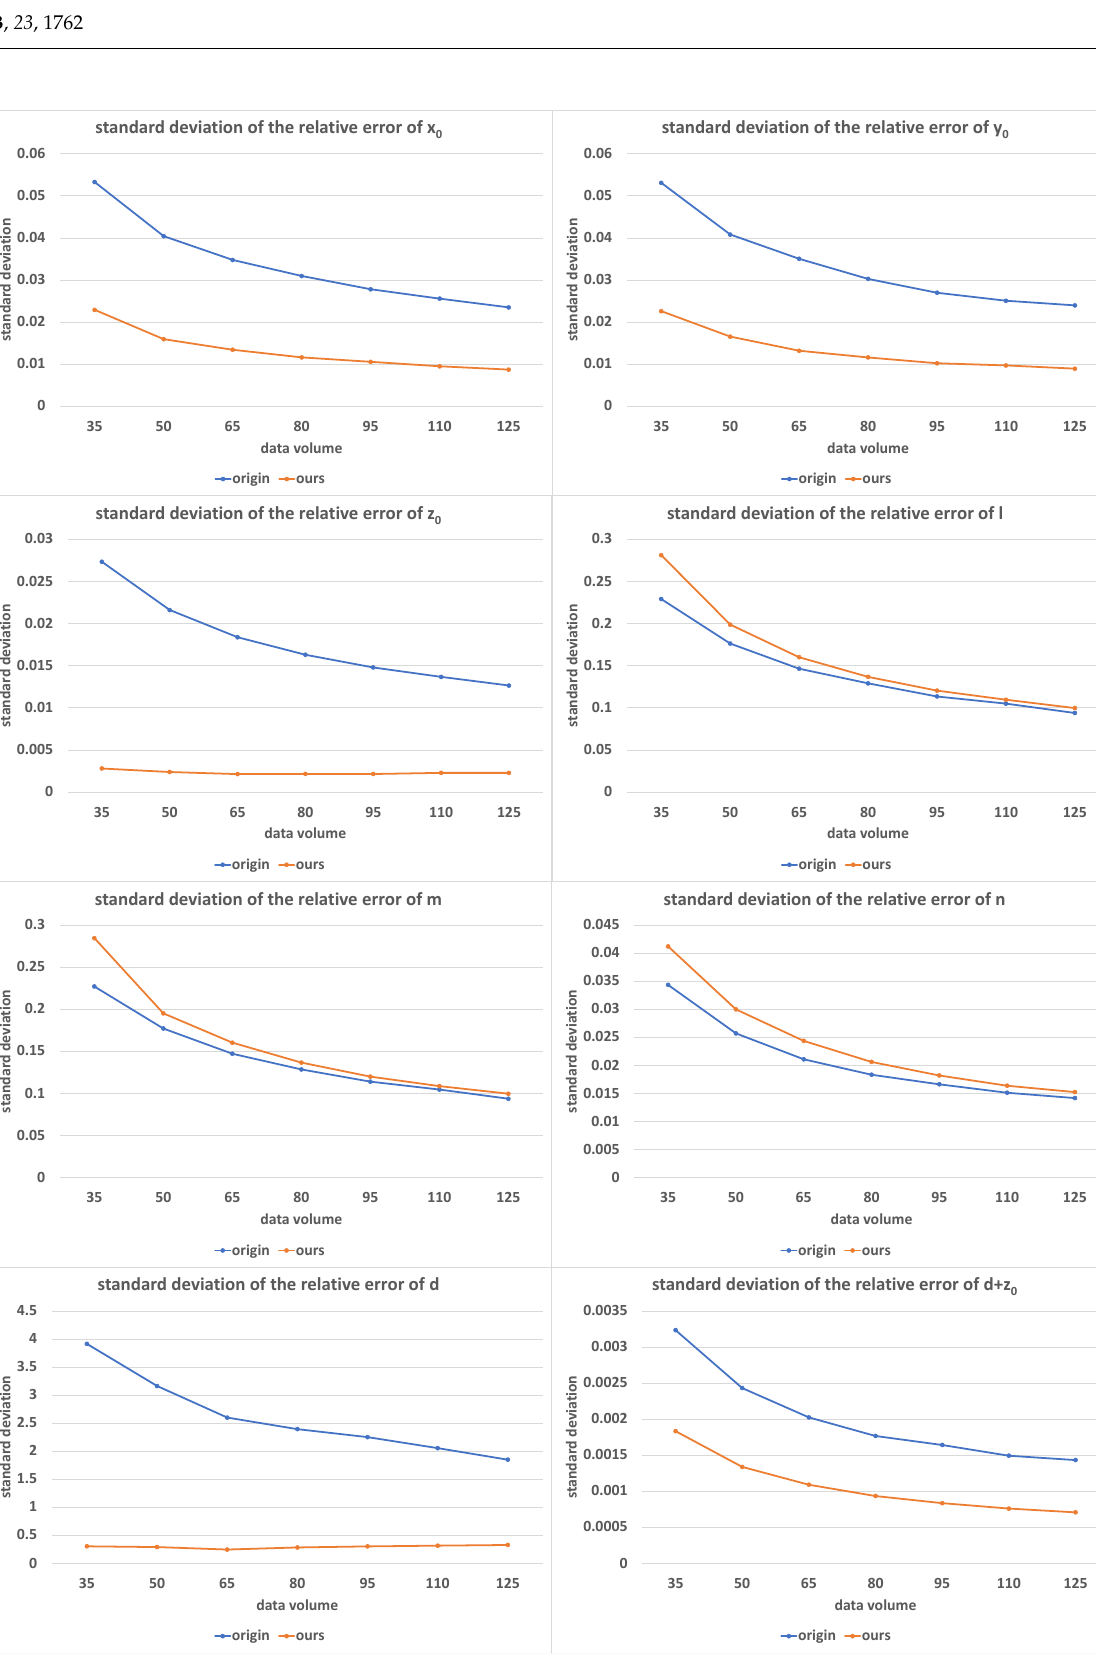
Figure 11. The standard deviations of relative errors of ( x 0 , y 0 , z 0 , l , m , n , d , d + z 0 ) with the increase in K with and without equation screening; the horizontal axis was measured in equation